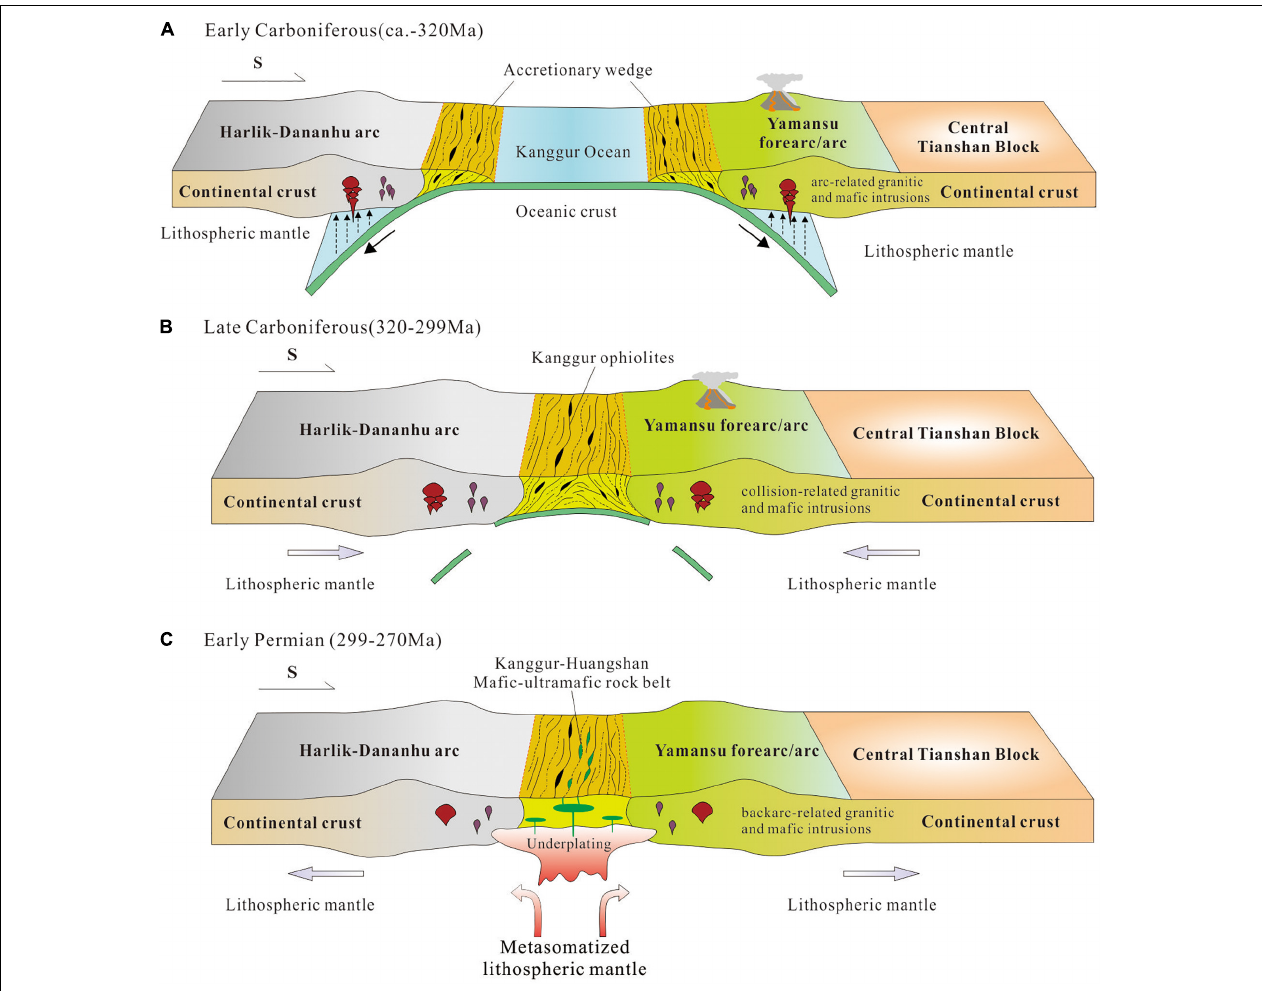
FIGURE 11 | The tectonic evolution in the late Paleozoic of eastern Tianshan. (A) the two-way subduction and accretion of the Kangur ocean basin occurred in the Early Carboniferous; (B) closure of Kanggur ocean basin in Late Carboniferous; (C) post-collisional extensional environment in Early